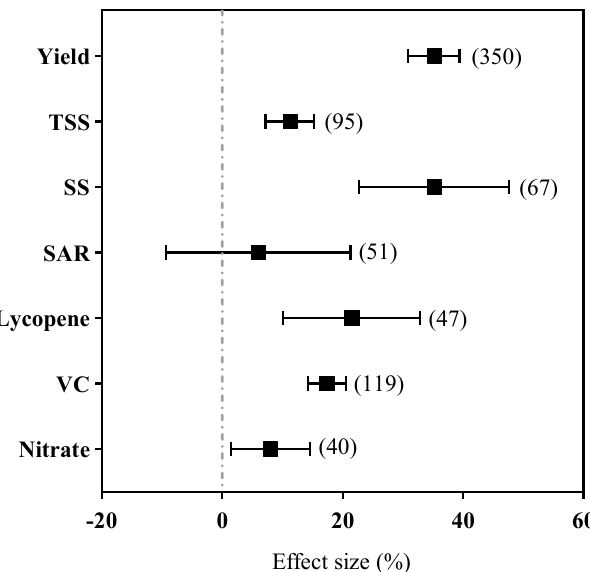
Figure 2. Organic fertilizers’ effect on tomato yield and quality. Points represent the mean effect, while bars represent 95% confidence intervals. The numbers at the right side of the confidence intervals represent the sample sizes. TSS, total soluble solids; SS, soluble sugar; SAR, sugar/acid content ratio; VC, vitamin C.